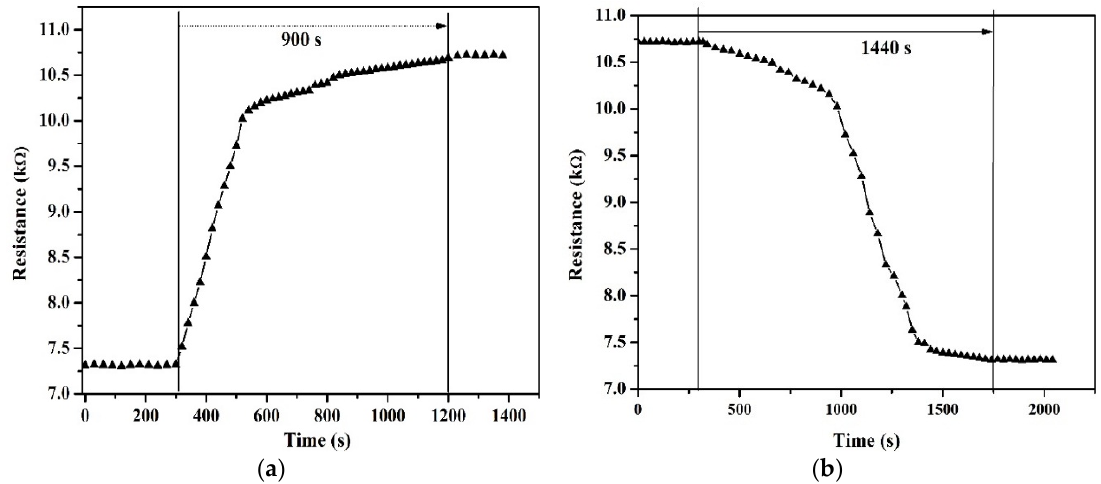
Figure 6. ( a ) Rise time and ( b ) fall time of non-suspended carbon nanotubes. The humidity was varied from 98% to 15% RH in steps of 10% RH decreases every 20 s.